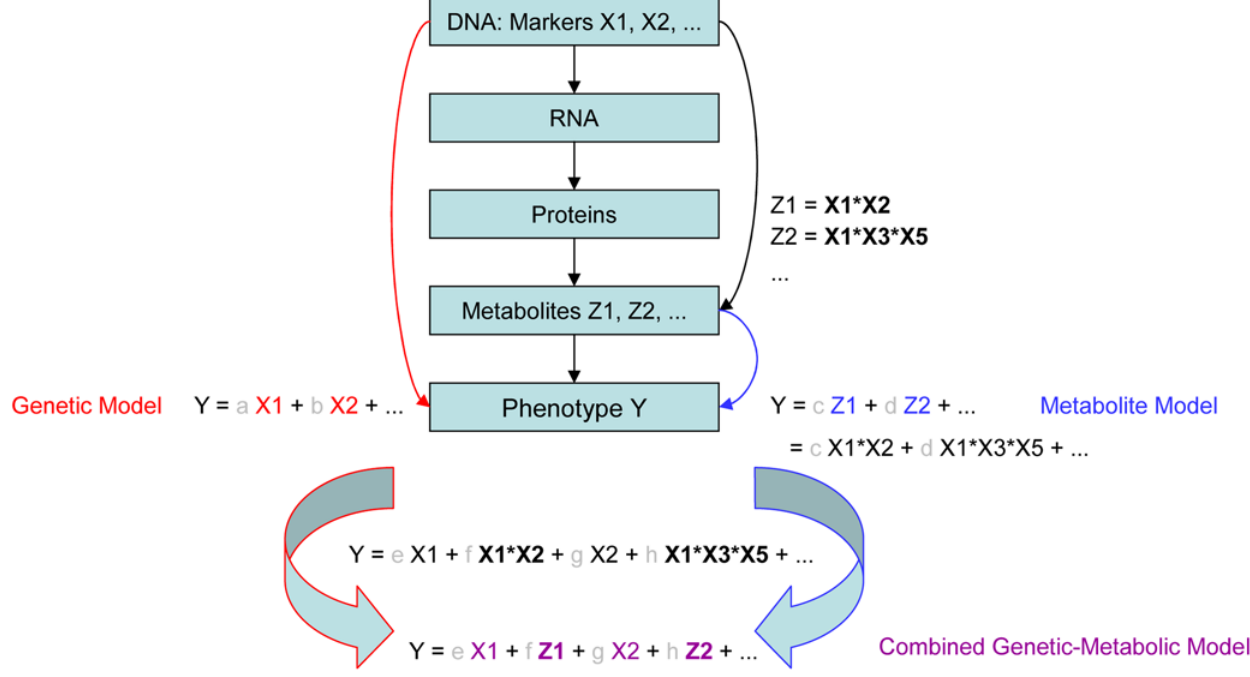
Figure 5. Simplified display of the idea behind the modelling for the different predictor sets. The chain of causality from genes to phenotype is displayed here. Since genes are at the starting point of the causal chain, one established way to model a phenotype Y is to use genetic markers X and combine them linearely (genetic model in red). Using instead predictor variables Z, which are close to the phenotype, such as metabolites, presents another promising way to predict a complex phenotype, since those variables integrate already parts of the complex gene interactions (represented by products Xi*Xj). The advantage is that we do not need to know, which genes actually interact in which way, and that the model can stay simple. It just linearely combines metabolite variables, thus integrating non-linear interactions indirectly (metabolite model in blue). In the end, one might use a combination of both approaches, i.e. combining different levels of the causal chain, to explain as much as possible of the complex phenotype. Hence one integrates linear relationships concerning the response as well as non-linear gene interactions, while sticking to the simple model ansatz of a linear combination of genetic predictors X and metabolite variables Z (combined model in violet).